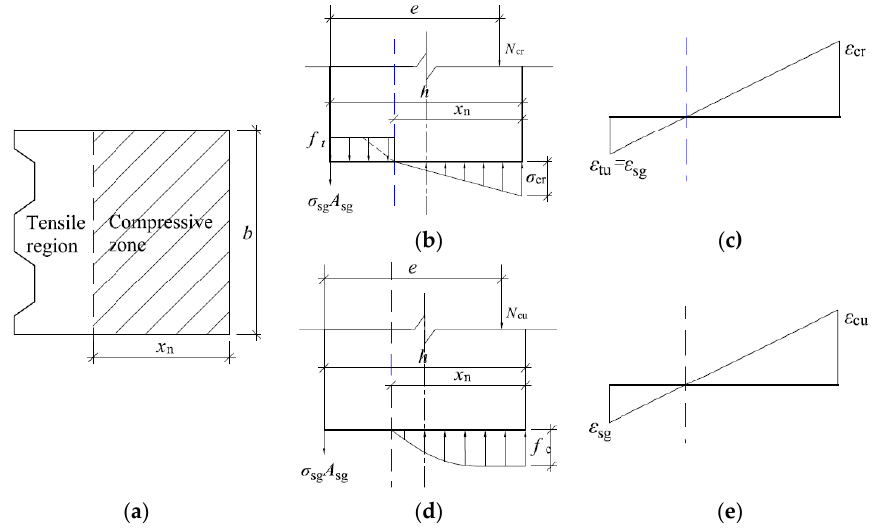
Figure 12. Sketch of bearing capacity calculation of specimen by corrugated steel plate reinforcement method. ( a ) Cross-sectional view; ( b ) Cross-sectional stress distribution at cracking; ( c ) Cross-sectional strain distribution at cracking; ( d ) Cross-sectional stress distribution during crush damage; ( e ) Cross-sectional strain distribution during crush damage.